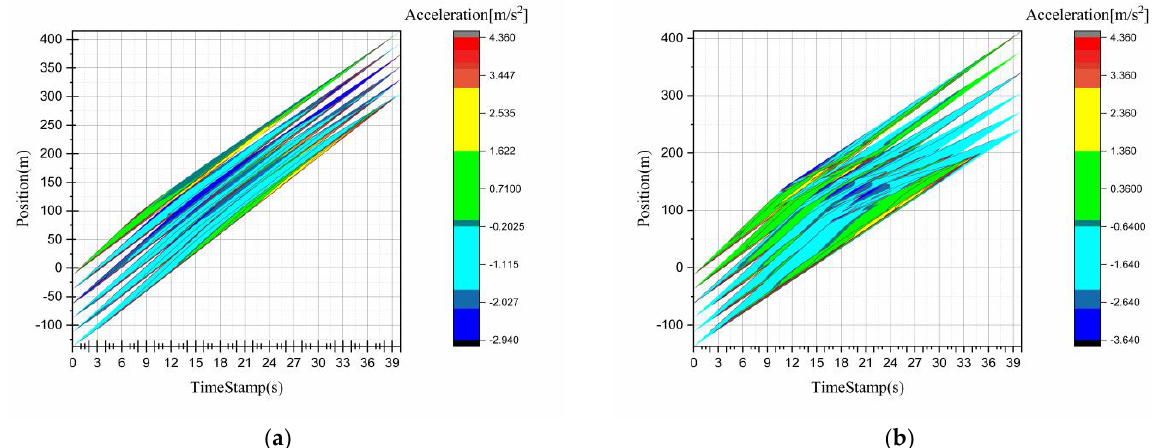
Figure 10. Acceleration heatmap of CAVF fleet and CACCNF fleet under scenario 1: ( a ) CAVF acceleration heatmap; ( b ) CACCNF acceleration heatmap.